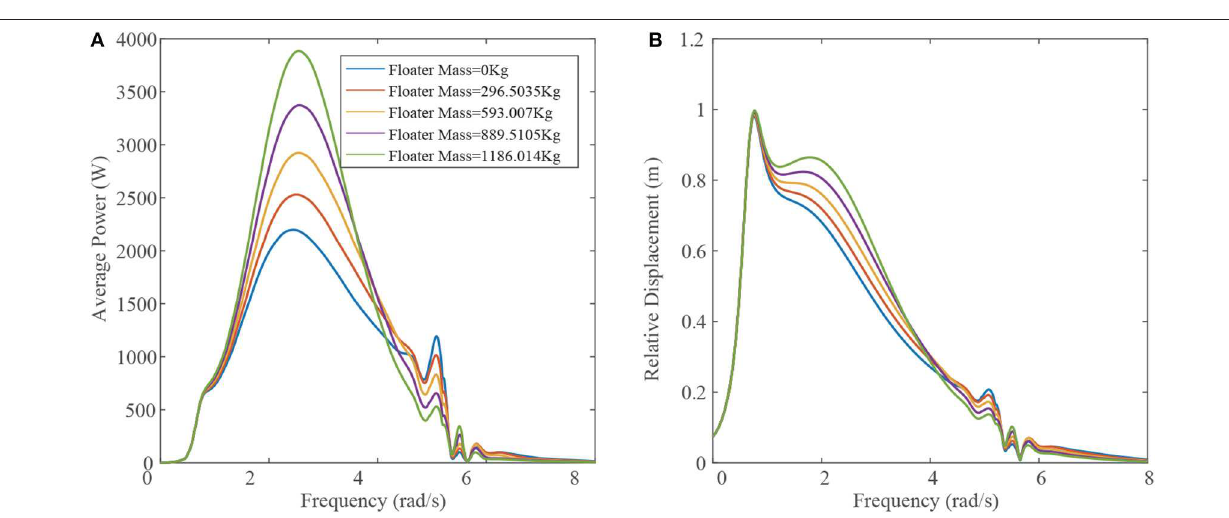
FIGURE 6 | Extracted average power (A) and relative displacement (B) vs. wave frequency at various floater